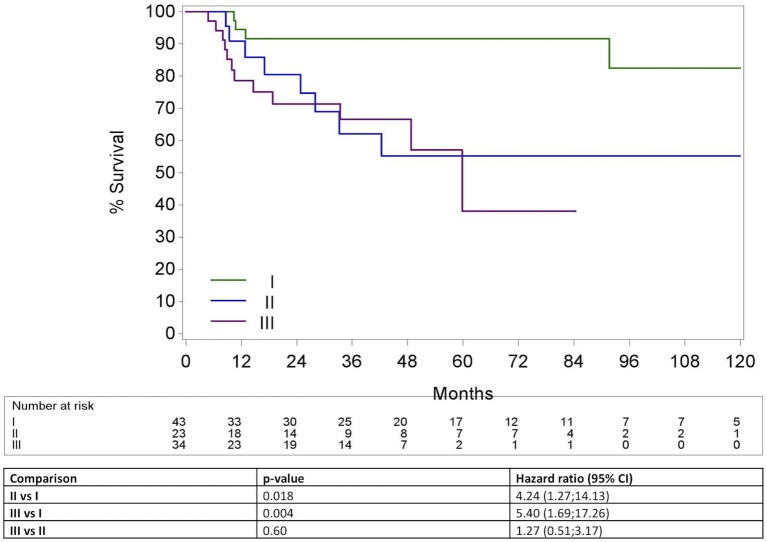
Kaplan-Meier curve for overall survival by stage group according to the TNM 8th edition for HPV positive oropharyngeal squamous cell carcinoma. Log-rank test: p = 0.006; Hazard Ratio >(<) 1 means higher (lower) risk for the first category; HPV, Human papillomavirus.